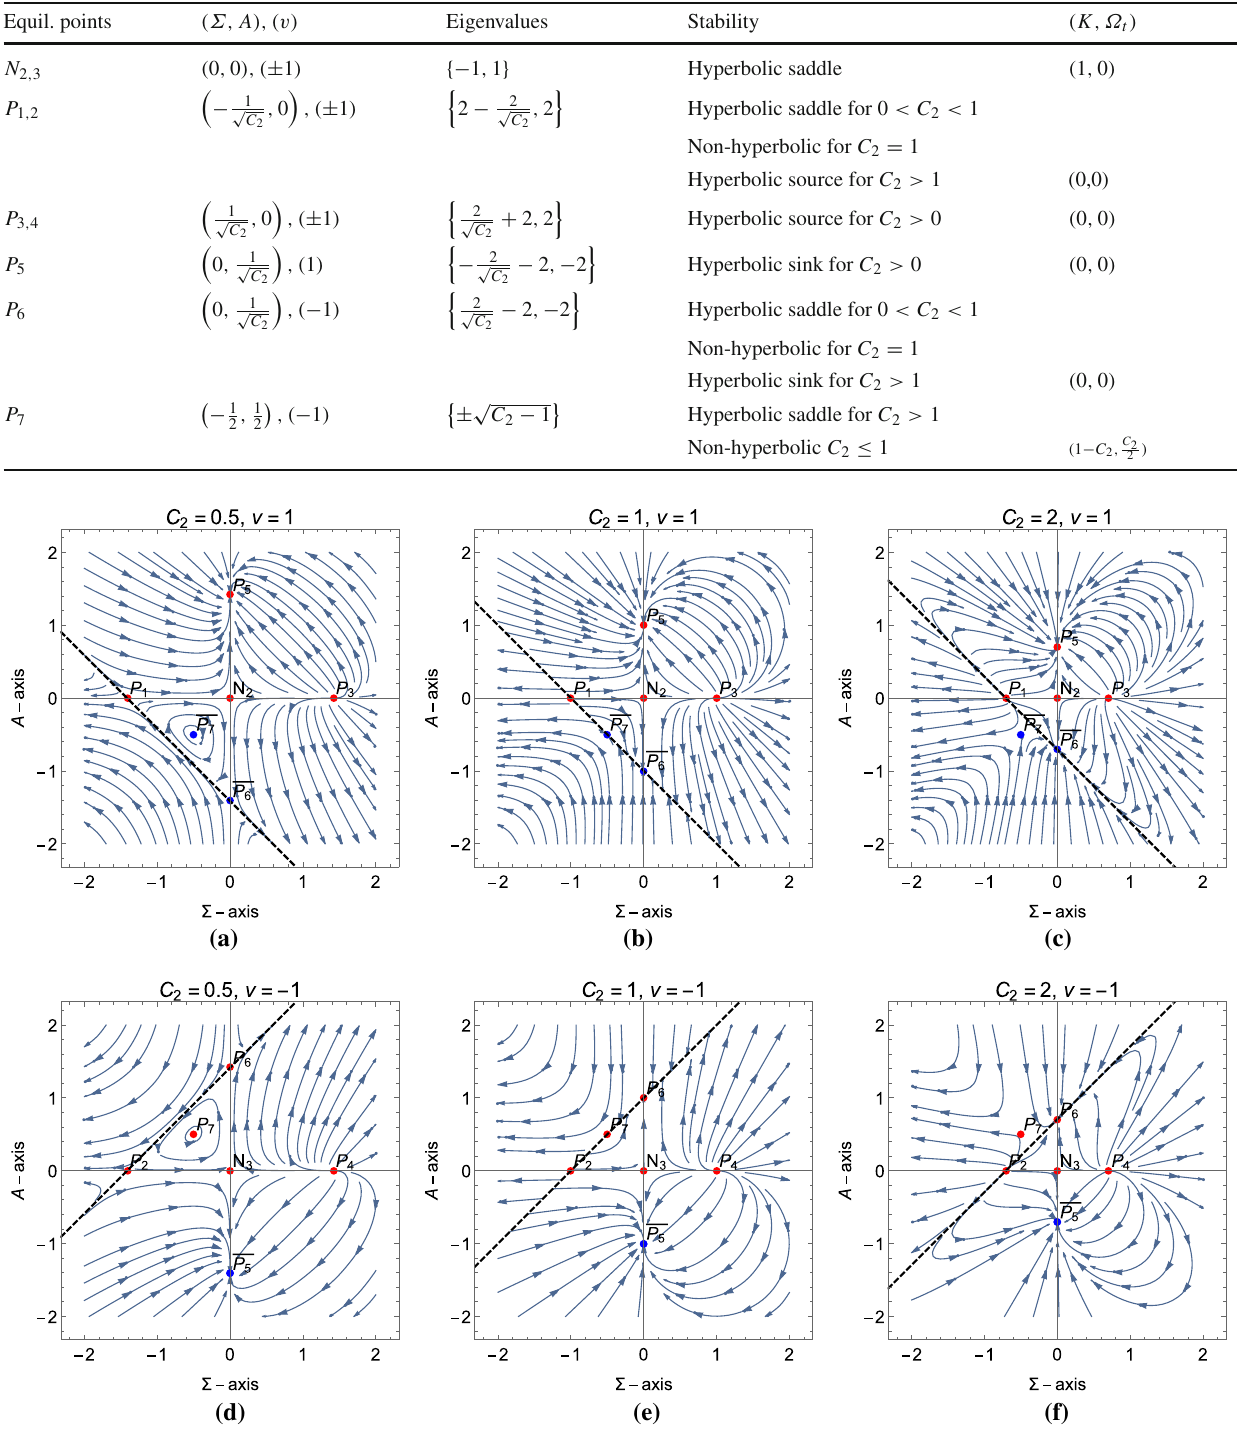
Fig. 3 Some orbits of the systems (58) with v = 1 , − 1, for different parameter choices. The points P 5 , P 6 , P 7 are included, where P i denotes the symmetric points of the point P i . The dotted line represents H − (resp. H − = H + ) for C 2 =